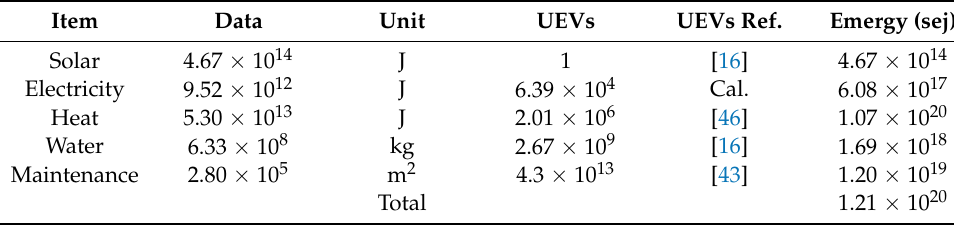
Table 4. Emergy table of operation phase.